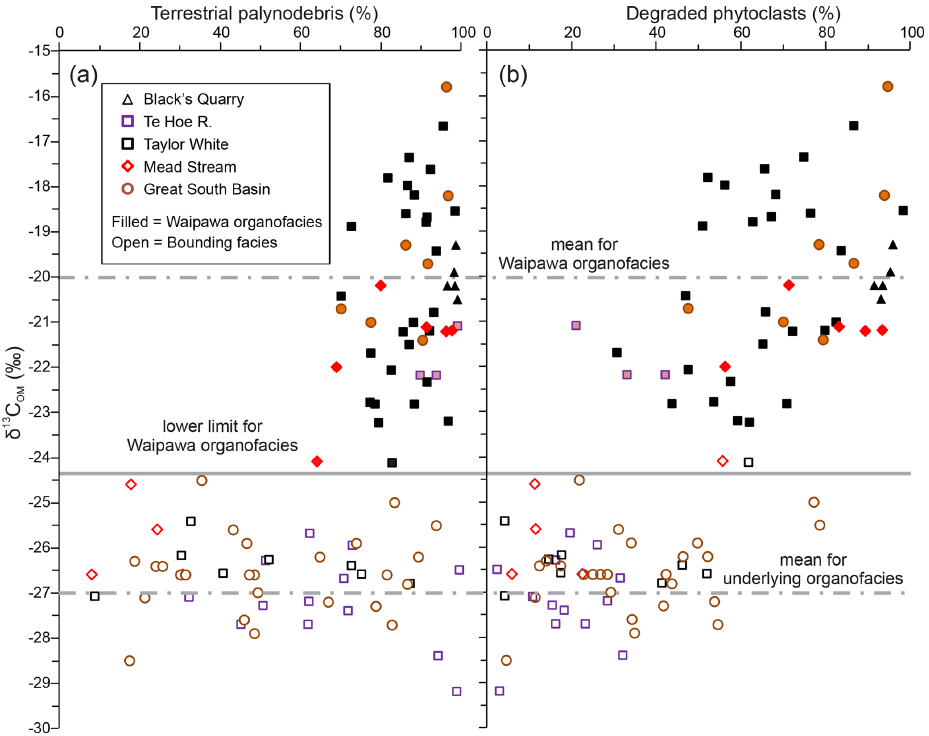
Figure 4. Correlation of δ 13 C OM with (a) terrestrial palynodebris and (b) degraded phytoclasts in five onshore sections and four drill holes in the Great South Basin (Toroa-1, Pakaha-1, Kawau-1A and